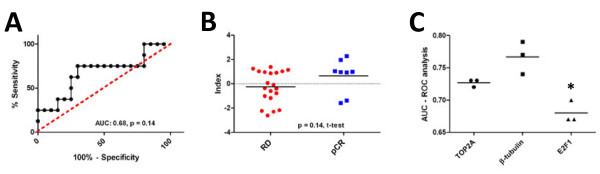
TOP2A and β-tubulin indices are more accurate than a similarly derived proliferation index.A) ROC analusis of TOP2A index and patient response to neoadjuvant docetaxel therapy ( p = 0.14). B) TOP2A index scores of patients who experienced pCR or had RD after neoadjuvant docetaxel chemotherapy ( p =0.14, t-test). C) The TOP2A and β-tubulin indices outperform an E2F1-derived proliferation at predicting response to neoadjuvant chemotherapy in multiple patient datasets (* p <0.05, ANOVA, Tukey’s test).